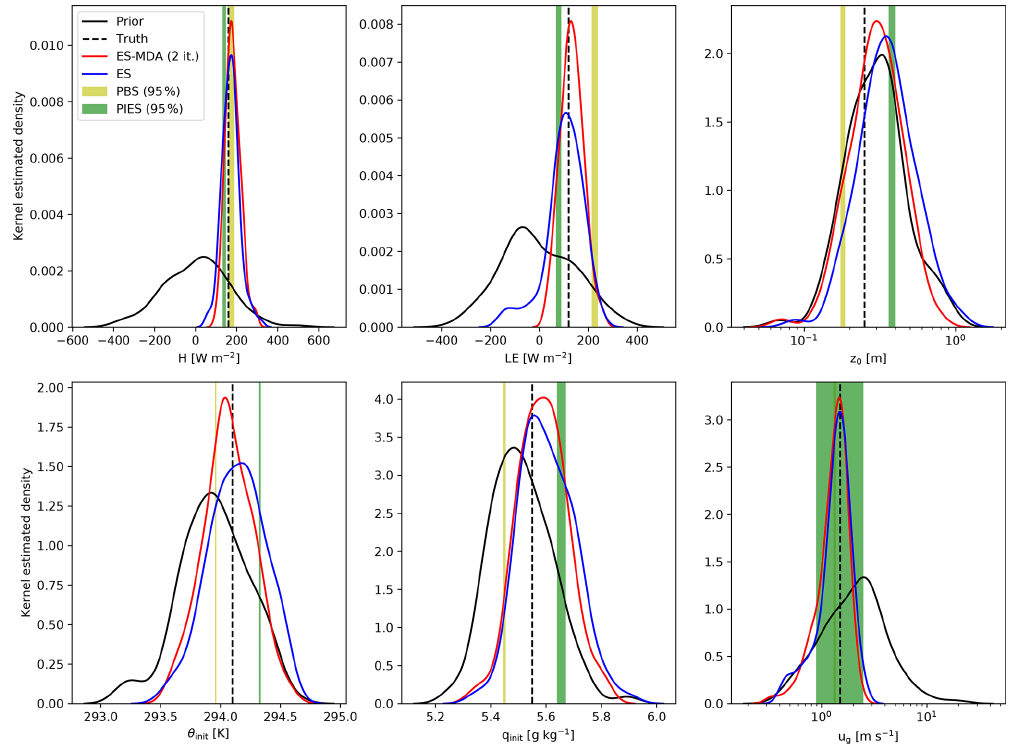
Figure 3. Marginal parameter distributions for the prior (black) as well as the ES-MDA (with N a = two iterations, red), ES (blue), PBS (yellow shading shows the central 95th percentile range), and PIES (green shading shows the central 95th percentile range) posterior estimates along with the location of the truth (black dashed vertical line) in a synthetic experiment with one drone flying a step profile for 12min. Table 1. Average evaluation statistics across all 16 synthetic experiments for different DA